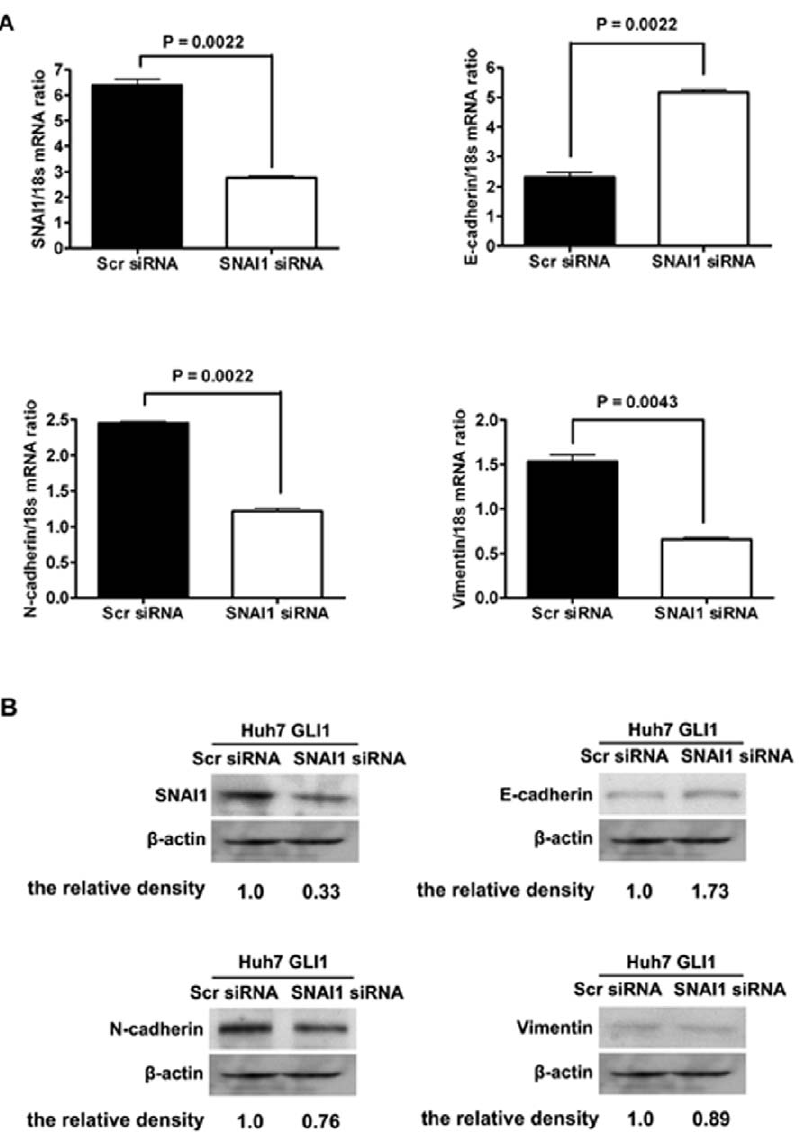
Figure 6. Knockdown of SNAI1 reverses the EMT phenotype induced by GLI1 in HCC cells. (A) SNAI1 siRNA decreases SNAI1 expression in Huh7 cells transfected stably with GLI1 expressing plasmid. SNAI1 siRNA increases E-cadherin expression (B) and decreases the expression of both N- cadherin (C) and Vimentin (D) in Huh7 cells transfected stably with GLI1 expressing plasmid.